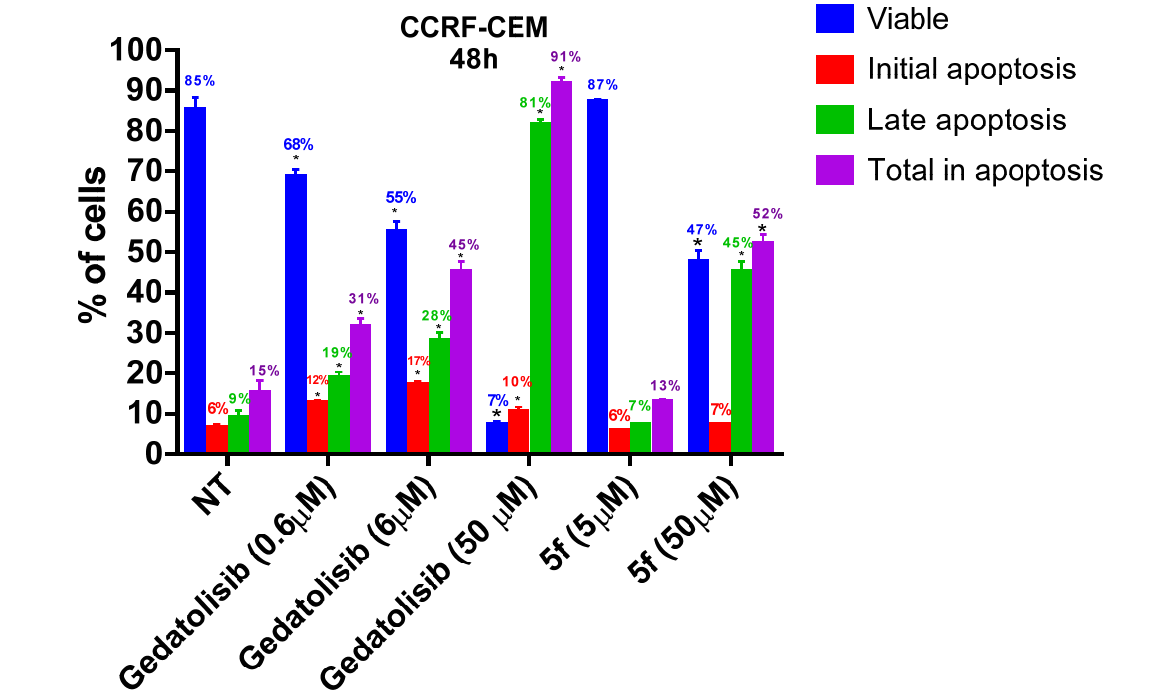
Figure 4. Evaluation of phosphatidylserine externalization and cell membrane integrity caused by gedatolisib ( 4 ) and LASSBio-2252 ( 5f ) against CCRF-CEM cell line in 48 h. Data presented as mean ± standard error of the mean of three independent experiments. * p < 0.05 compared to the untreated group (DMSO 1%).